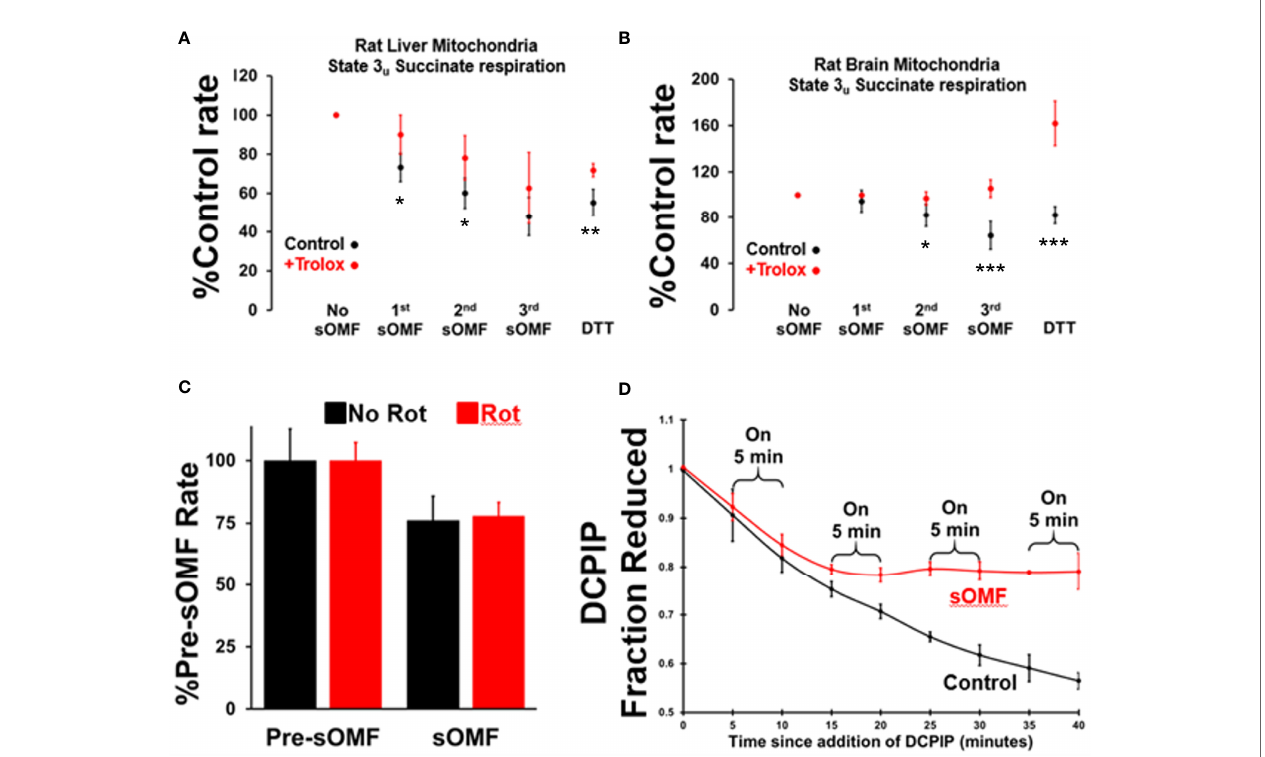
FIGURE 3 | Spinning magnetic fi elds target SDH in rat liver and brain mitochondria. RLM (A) and RBM (B) were incubated with/without Trolox (15 m M) and the State 3 u (CCCP 2 m M), and respiration was measured with succinate/malonate (10 mM/500 m M). The mitochondrial suspensions were subject to three, 3-minute on/ off sOMF stimulation cycles. Rates were measured sOMF post-treatment and mean ± SD of n =4 replicants are presented. Noticeable is the almost complete protection afforded to brain mitochondria by Trolox, and that addition of 10 mM DTT boosts the respiration rate above that seen prior to sOMF treatment. t -tests were performed and symbols *, ** and *** show points where p <0.05, p <0.01 and p <0.005. (C) RLM maintained under State 3 u with succinate/malonate (10